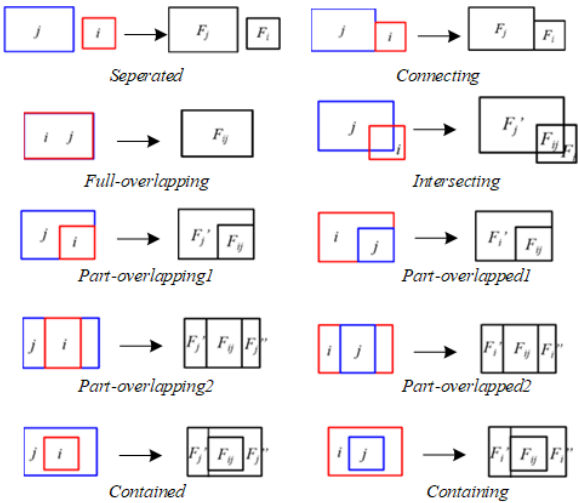
Figure 3. Extraction of facets based on 2D topological relations.